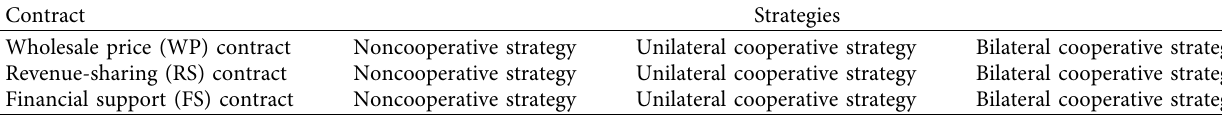
Table 2: Green advertising strategies in the O2O CLSC.